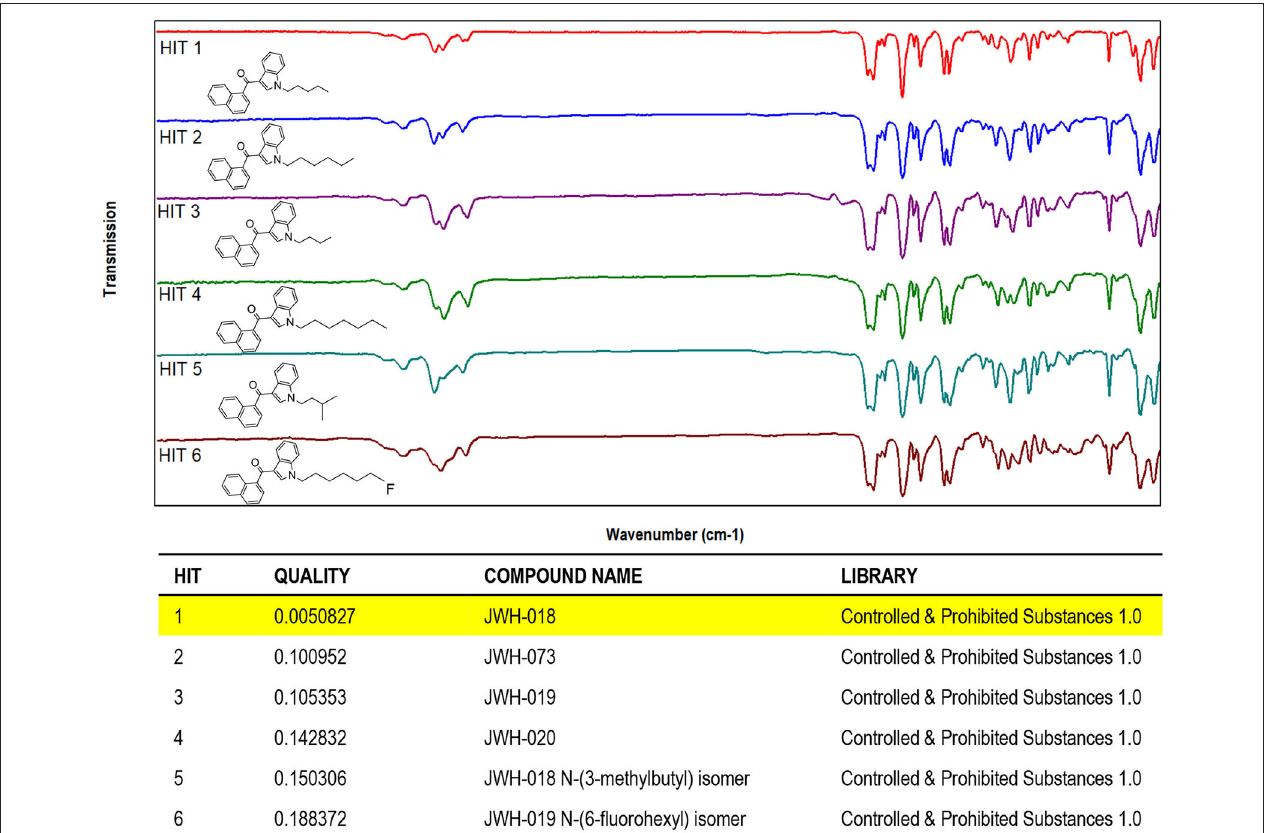
FIGURE 3 | Software window showing the library search results obtained for JWH-018 IR spectral data. (Top) IR spectra of JWH and its structural analogs (Hits 1–6). (Bottom) QMF obtained for JWH-018 against correct and incorrect matches. Quality is expressed in 0–1 units (with 0 representing the maximum value for similarity or quality